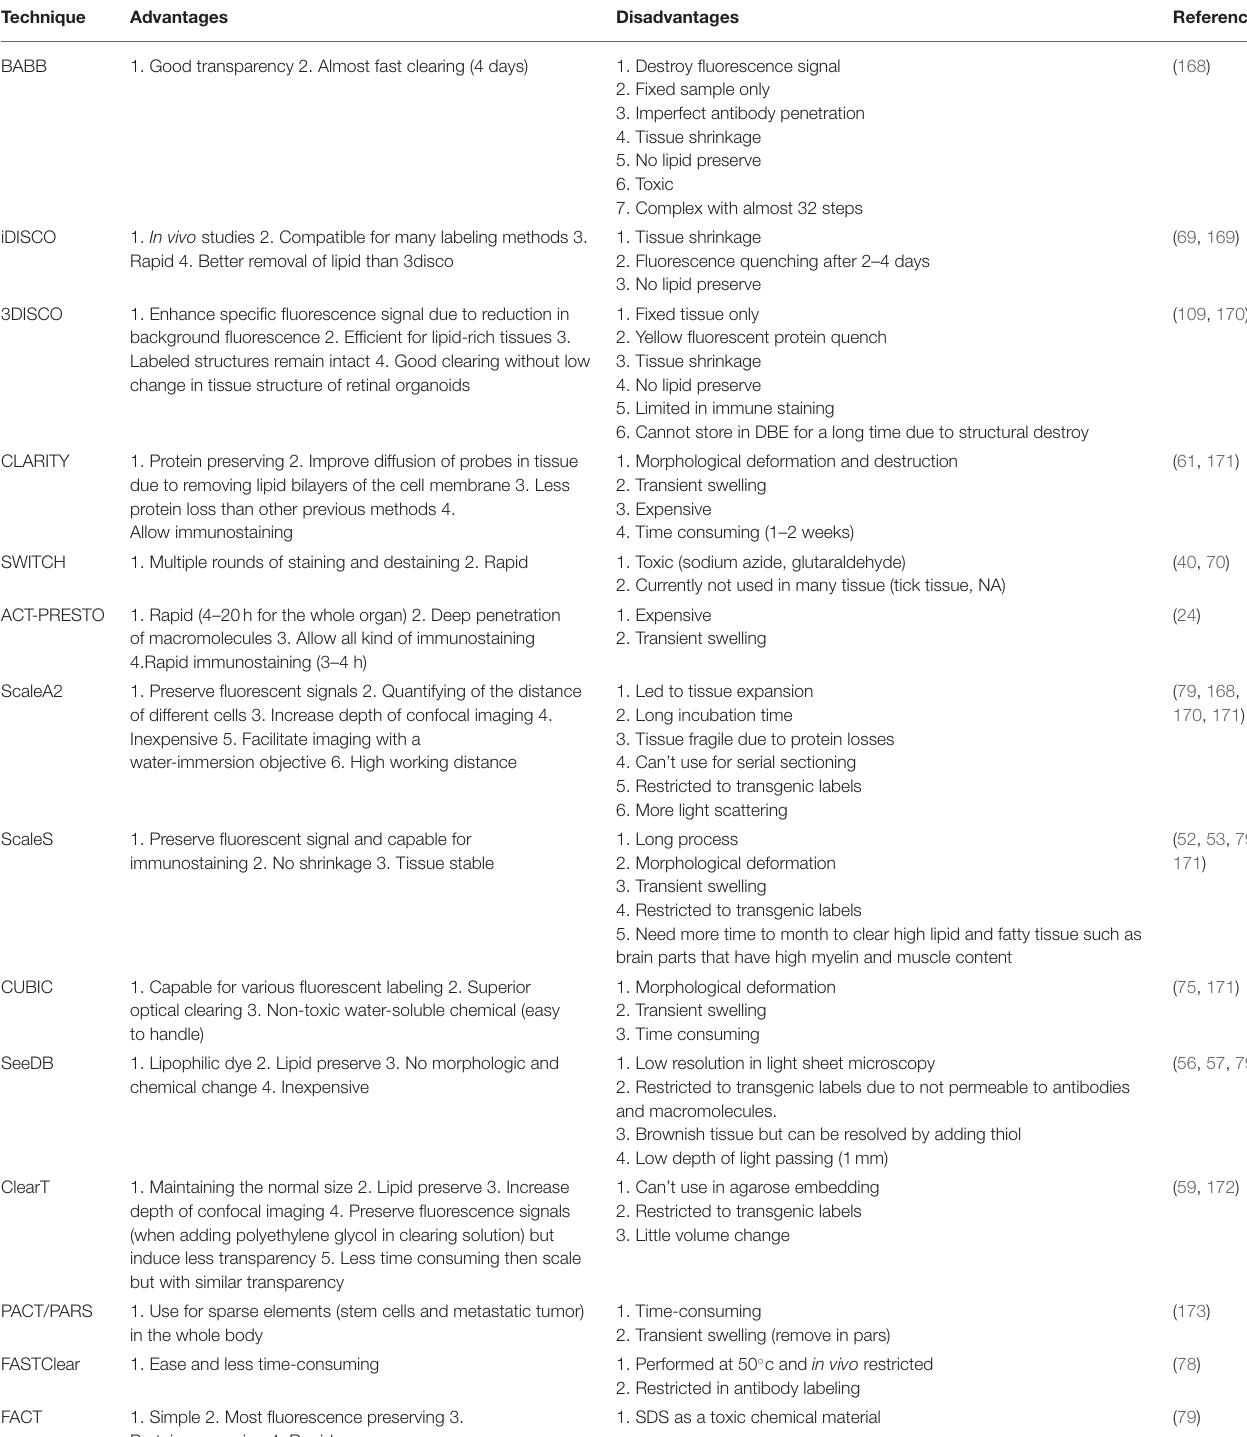
TABLE 5 | Advantage and disadvantage of whole tissue clearing methods in stem cell